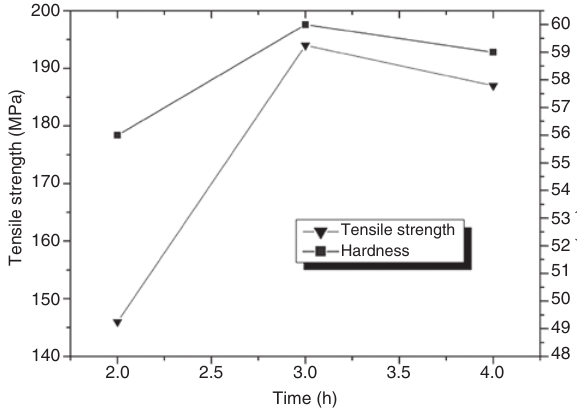
Figure 8 The variations in the effect of hot pressing time on tensile strength and hardness of